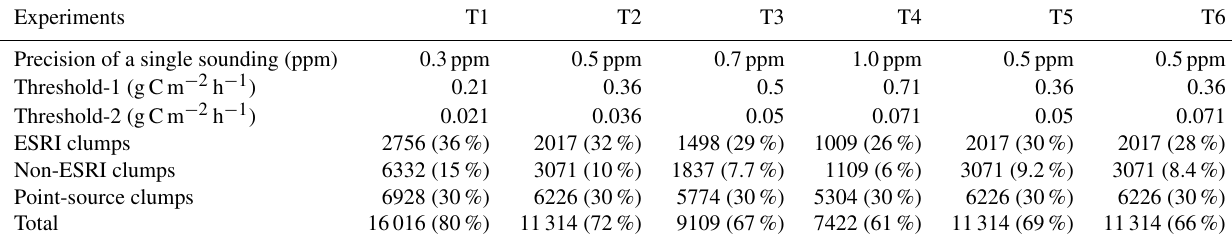
Table 3. The sensitivity of the number of emission clumps (integers before parentheses) and the fractions of emissions covered by the emission clumps (values in the parentheses) to the global total of the thresholds in the clump algorithm.